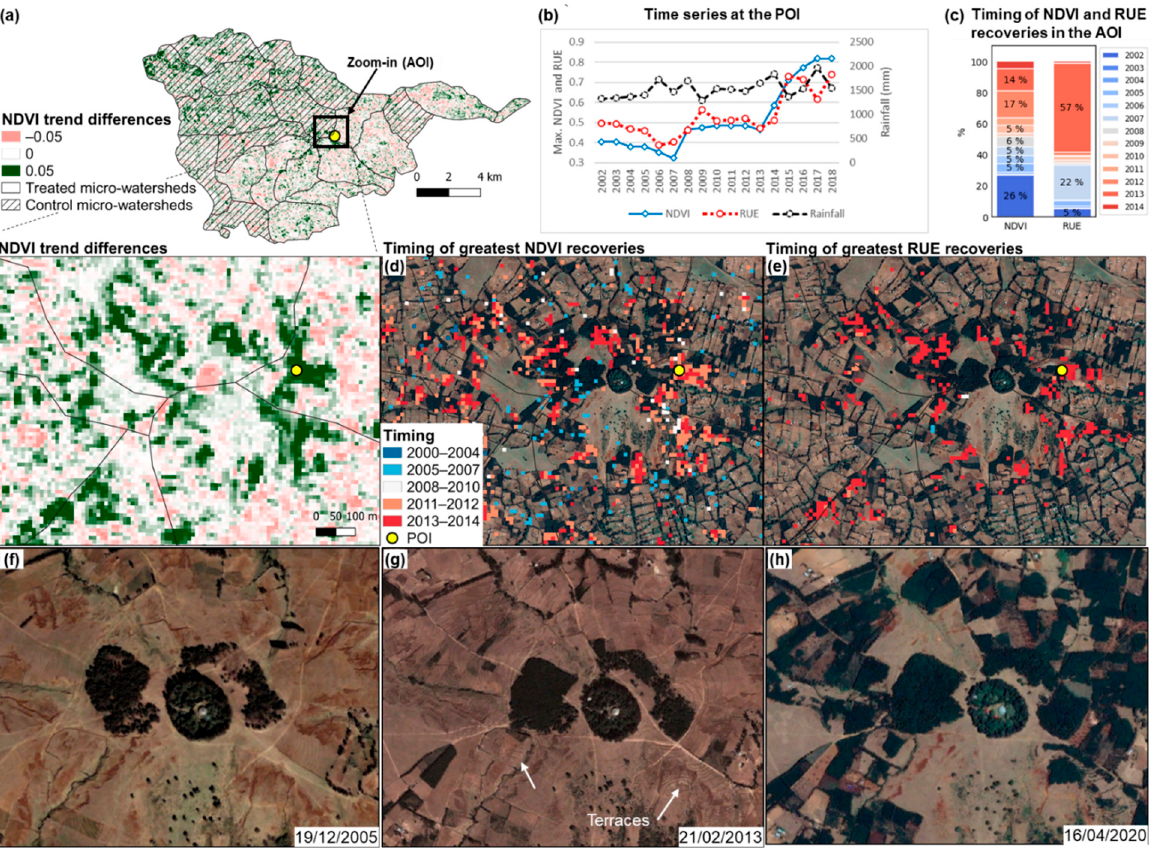
Figure 6. Watershed of Banja. ( a ) NDVI trend differences (slope of 2011–2018 minus slope of 2002–2010); ( b ) Time series at the POI; ( c ) Timing of the largest NDVI and RUE recoveries in the AOI; ( d ) Spatial distribution of the timing of the largest NDVI recoveries and of ( e ) RUE recoveries in the AOI; VHR images showing ( f ) mainly unterraced hillside in 2005, ( g ) the establishment of terraces in 2013 and ( h ) expanded tree cover area in 2020.